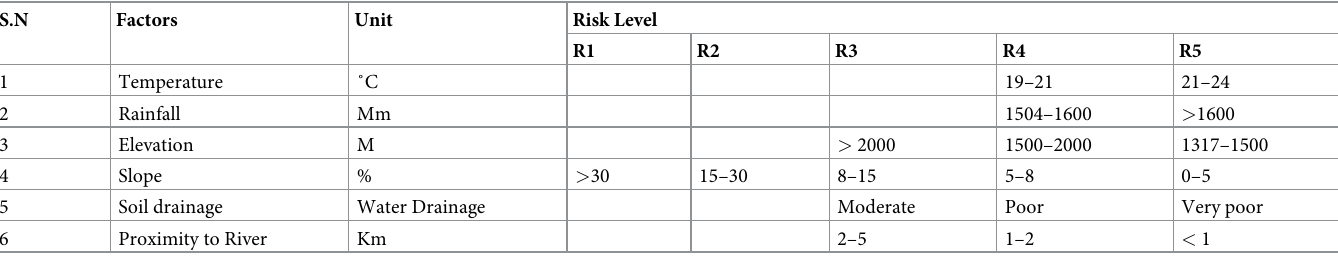
Table 1. Standardized value assigned for physical factors of malaria risk